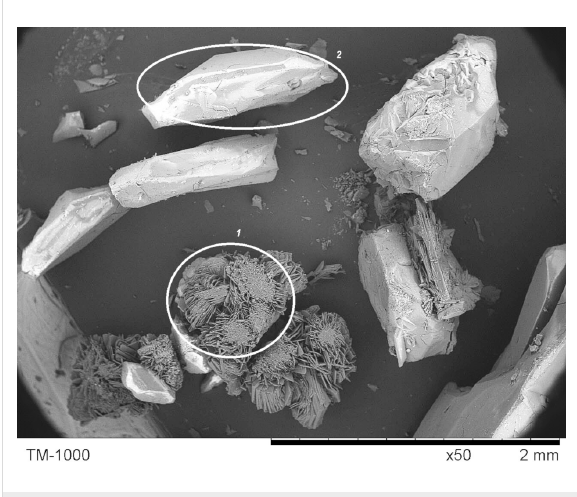
Figure 4: SEM image of F-1 with an F-1a phase.